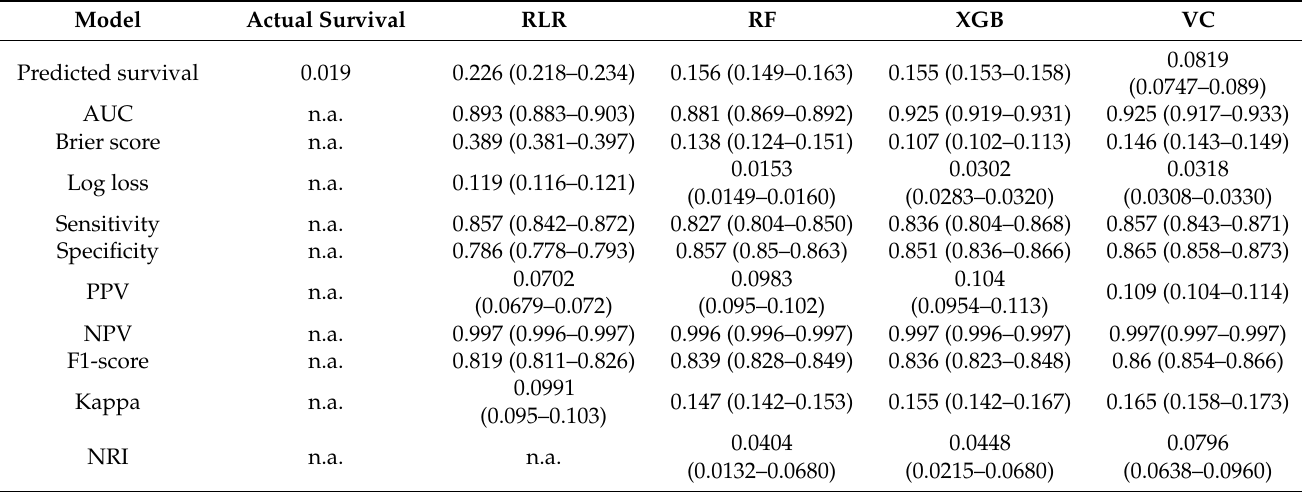
Figure 1. Receiver Operating Characteristic (ROC) and area under the curves (AUC) of regularized logistic regression (RLR), random forest (RF), extreme gradient boosting (XGB), and voting classifier (VC) for binary neurological outcome at hospital discharge. The colors of the curves and shaded regions represent the mean ROC and standard deviation of each model, respectively. The AUCs of the models and their 95% confidence intervals (CIs) are shown in the legend. The p -values for the hypothesis tests of the differences between the VC and the other models are also indicated in the legend. Table 2. The ratio of predicted good neurological outcome, AUC, log loss, Brier score, and evaluation metrics for the models and their 95% CIs.